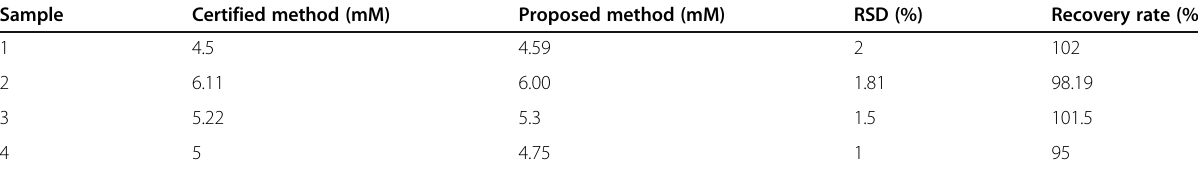
Table 2 Analysis of the glucose sensing performance of GO/CuO/FTO electrode